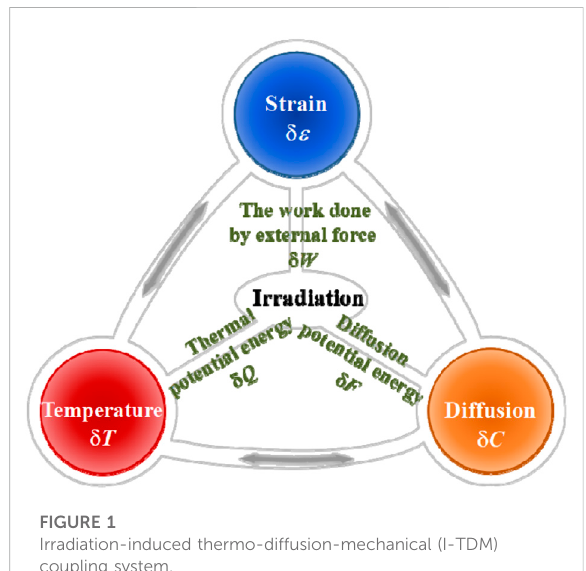
FIGURE 1 Irradiation-induced thermo-diffusion-mechanical (I-TDM) coupling